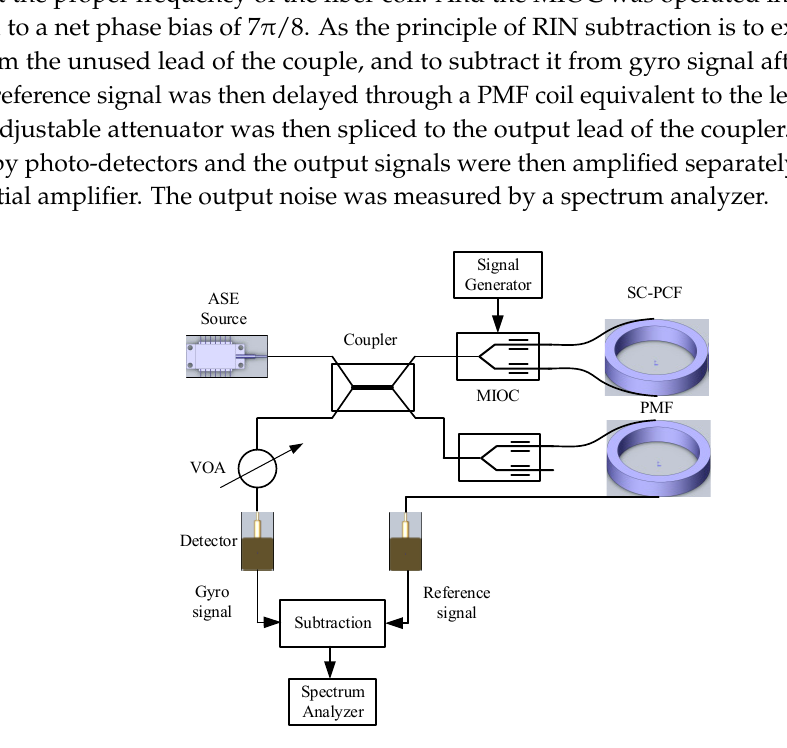
Figure 2. Experimental set-up for the measurement of the thermal phase noise in the SC-PCFOG.